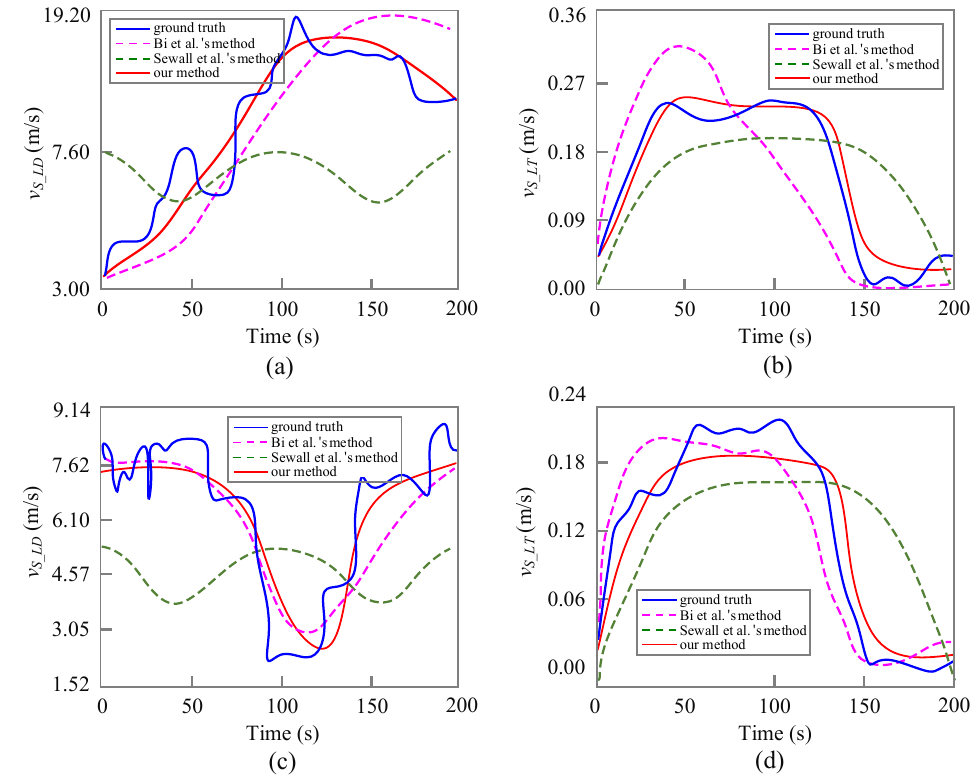
Figure 4. Speed comparison of different methods. ( a , b ) respectively denote the longitudinal and lateral speeds of V2719. ( c , d ) respectively denote the longitudinal and lateral speeds of V2823.